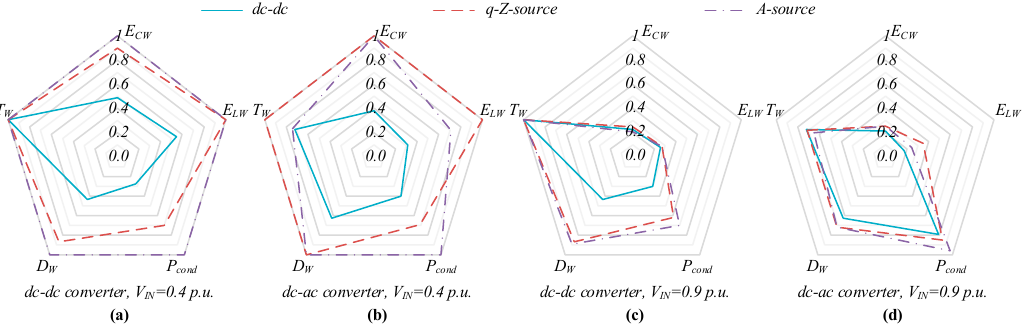
Figure 8. Comparative diagrams of the boost circuit, quasi-Z-source (qZS) networks, and A-source network: ( a ) dc-dc application with V in = 0.4 p.u, ( b ) dc-ac application with V in = 0.4 p.u., ( c ) dc-dc application with V in = 0.9 p.u., and ( d ) dc-ac application with V in = 0.9 p.u.